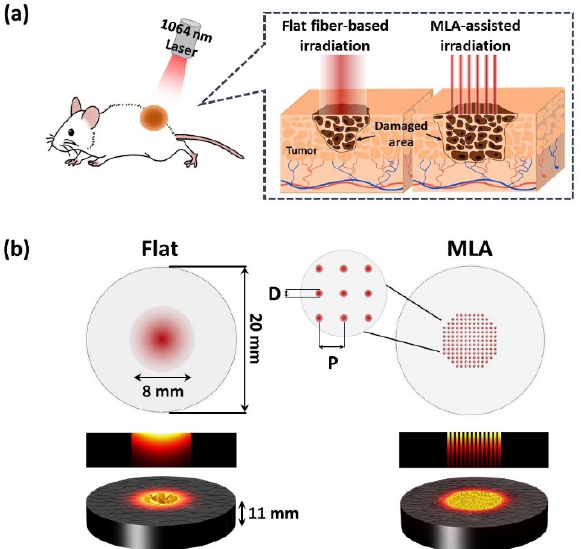
Figure 1. Schematic representations of ( a ) laser irradiation with flat fiber (Flat) and micro-lens arrays (MLA) on in vivo tumor model and ( b ) geometry of gelatin phantom (20 mm in diameter and 11 mm in thickness) for numerical simulation of laser irradiation with Flat and MLA (D = micro-beam diameter of 350 µm; P = distance between two consecutive micro-beams of 500 µm).